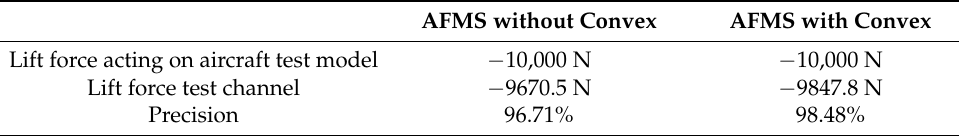
Table 2. Measurement accuracy of force support under vibration environment.